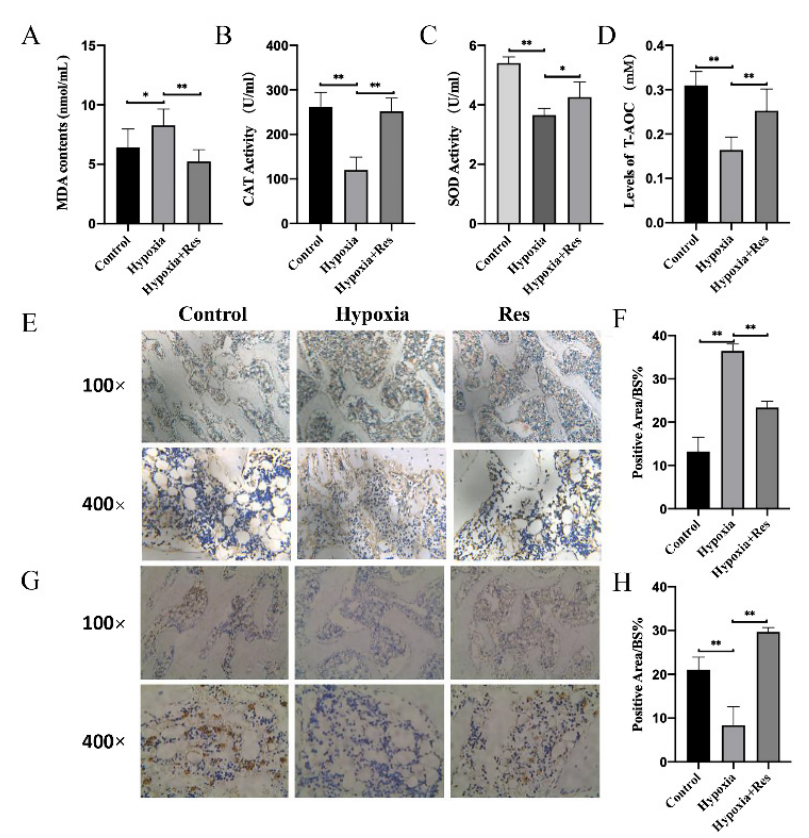
Figure 6. RES suppressed hypoxia-induced oxidative stress and the accumulation of HIF-1 α in rats. The serum content of ( A ) MDA and the activity of ( B ) CAT, ( C ) SOD, ( D ) T-AOC in rats from control group, hypoxia group, RES group were determined. ( E ) Immunohistochemistry staining results of HIF-1 α of rats from control group, hypoxia group, RES group and ( F ) quantification. ( G ) Immunohistochemistry staining results of PHD2 of rats from control group, hypoxia group, RES group and ( H ) quantification. Values were expressed as mean ± SD. * p < 0.05, ** p < 0.01; all the assays were repeated more than three times.